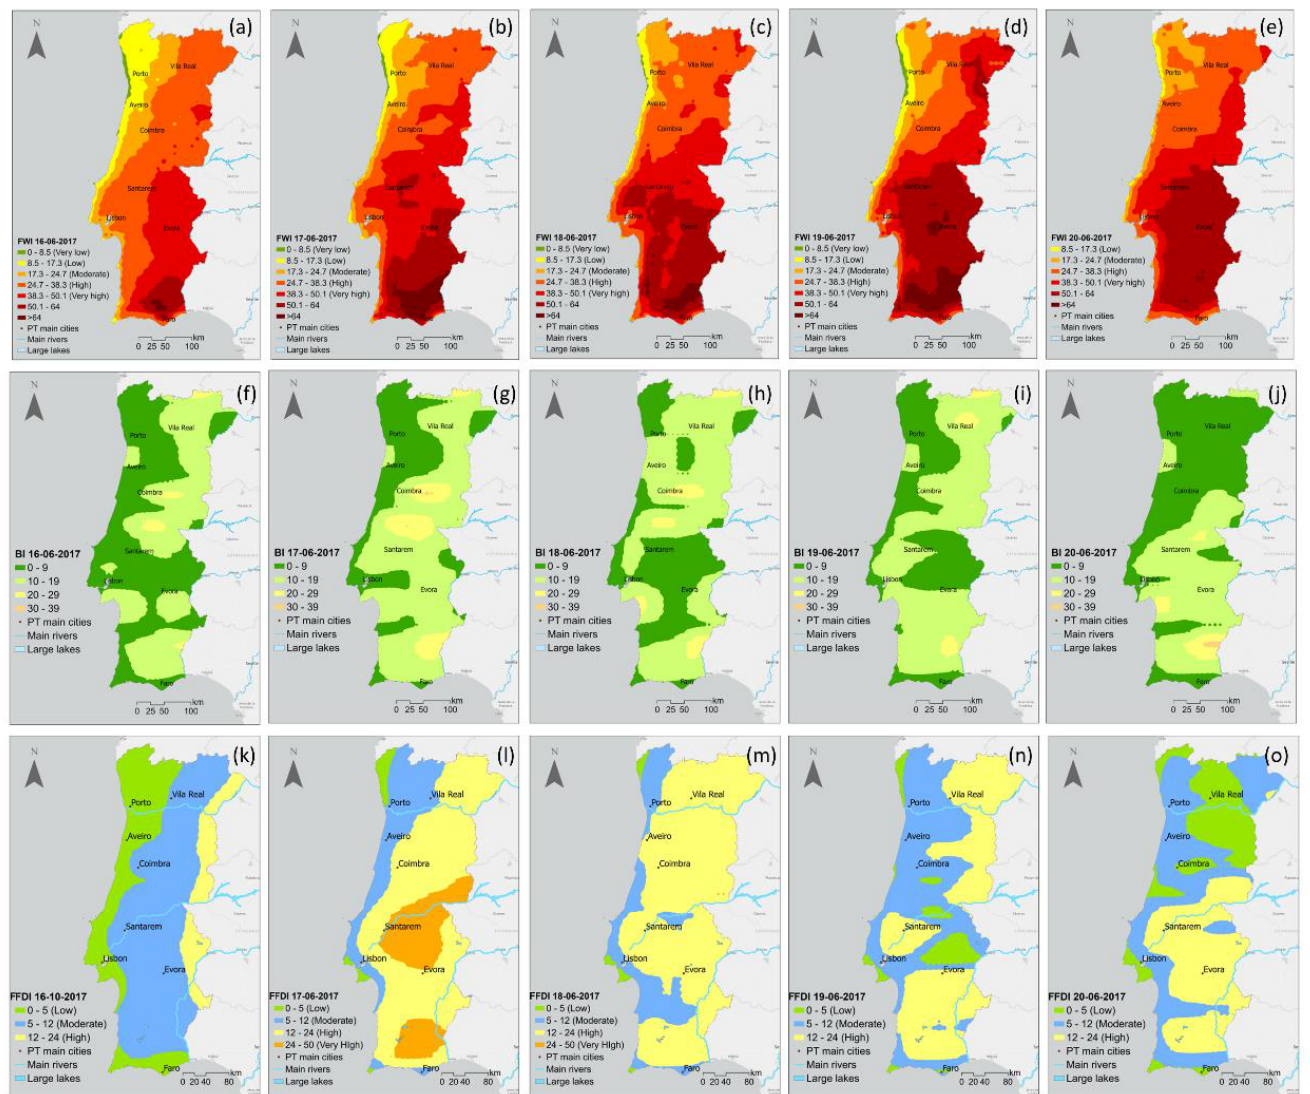
Figure 4. Daily mean values for ( a , f , k ) 16, ( b , g , l ) 17, ( c , h , m ) 18, ( d , i , n ) 19, and ( e , j , o ) 20 June 2017, for FWI (upper row), BI (middle row), and FFDI (lower row).